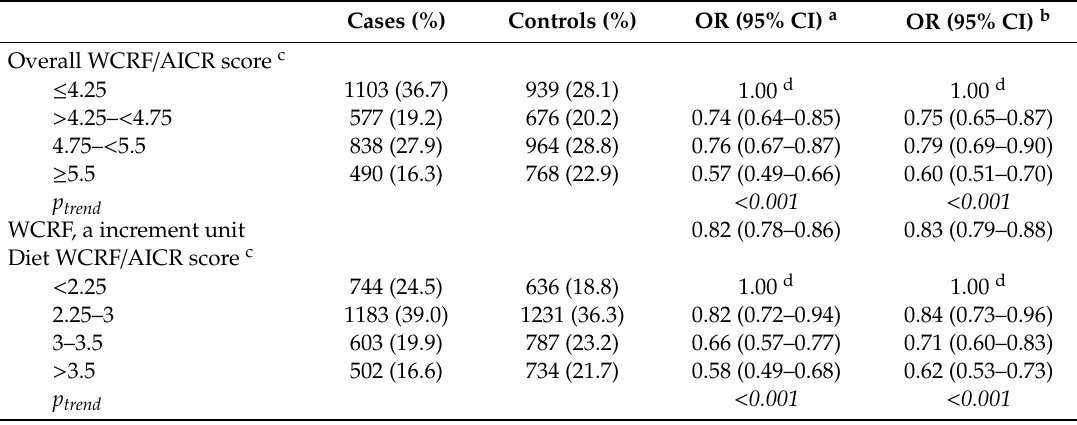
Table 3. Odds ratios (ORs) and corresponding 95% confidence intervals (CIs) for breast cancer according to the overall 2018 WCRF / AICR score and the diet-specific WCRF / AICR score. Italy and Switzerland,